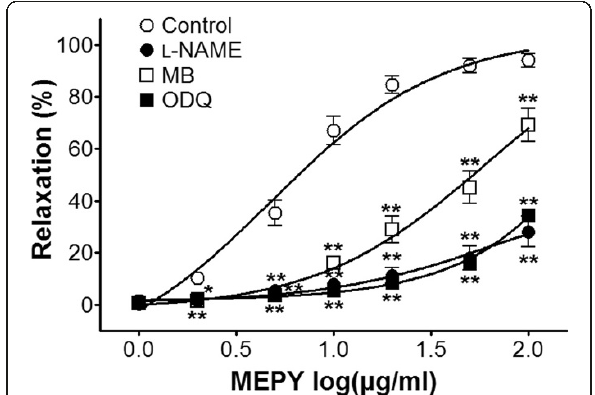
Figure 2 Relaxation responses induced by MEPY in endothelium- intact rat aortic rings pre-contracted with phenylephrine (PE,